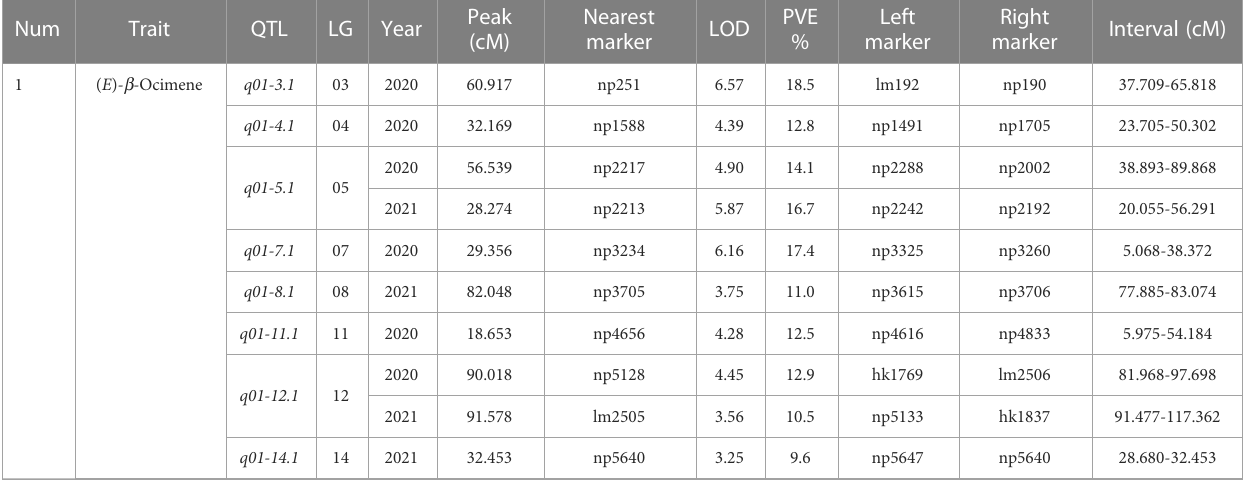
TABLE 3 Overview of QTLs associated with volatile terpene contents detected in the ‘ HD ’ × ‘ JX ’ F 1 population. Num Trait QTL LG Year